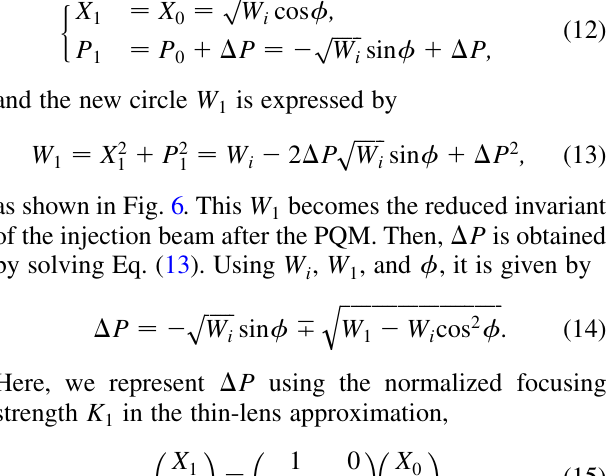
FIG. 7. (Color) Normalized strength K tion of the phase advance (cid:5) from the injection point and reduction ratio r .